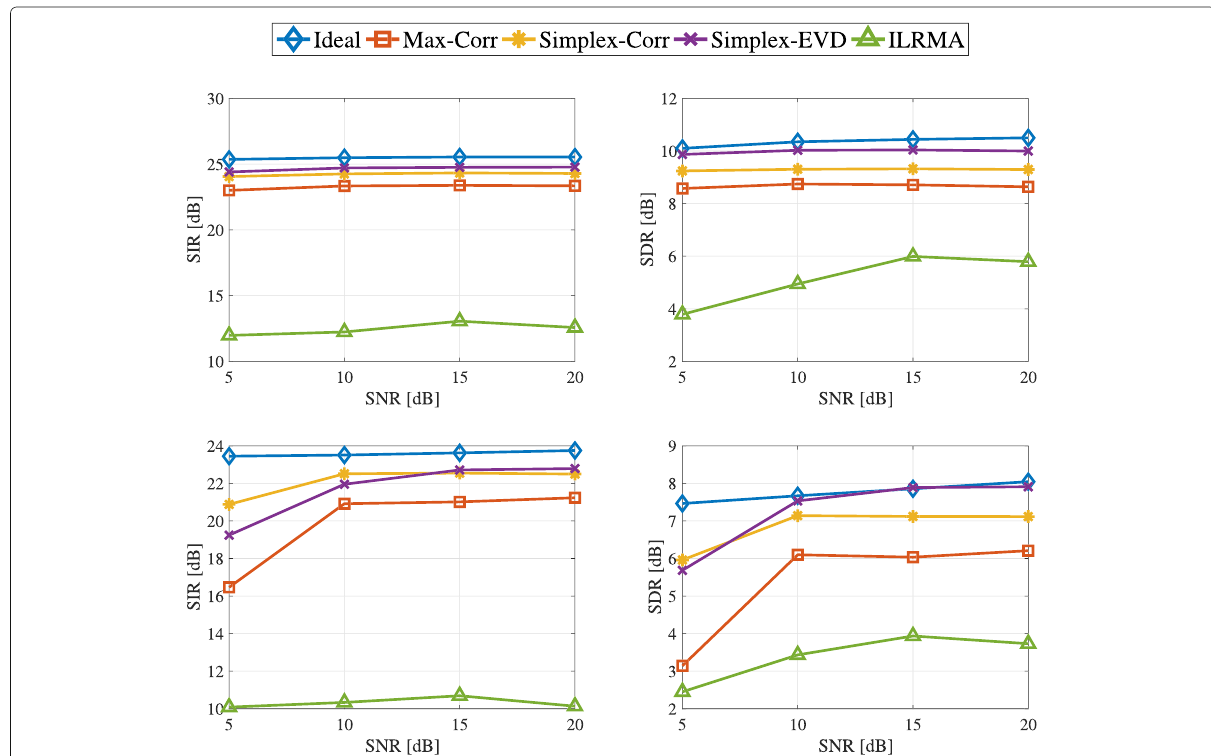
Fig. 5 Distributed array: evaluation for mixtures with J = 3 speakers with balanced activity—performance as a function of the SNR for a , b low and c , d high reverberation